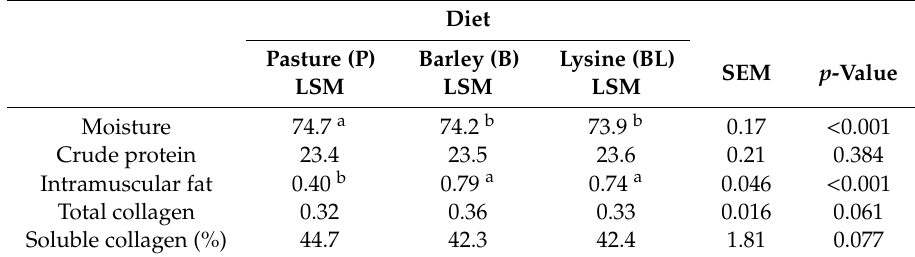
Table 3. Least Square Means (LSM) and Standard Error (SEM) of the chemical composition (g / 100 g muscle) of fallow deer longissimus lumborum muscle, after feeding with three di ff erent diets. Diet Pasture (P) Barley LSM